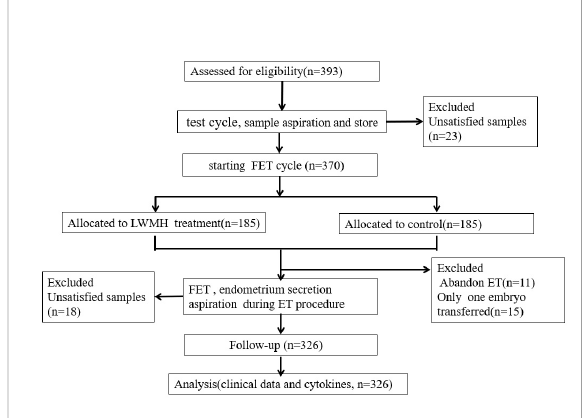
FIGURE 1 Flow chart of study . FET, frozen embryo transfer; LMWH, low molecular weight